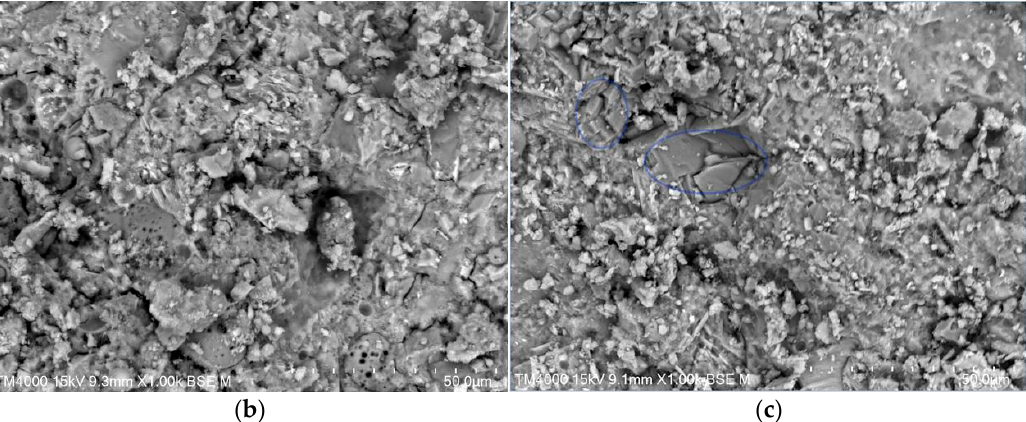
Figure 2. The morphology of specimens: ( a ) dolomite powder; ( b ) PDF0 at 90 days; ( c ) PDF5 at 90 days.